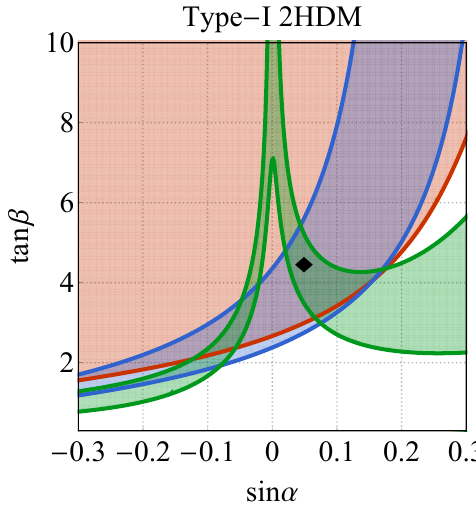
Figure 2 . Allowed/favoured regions in the type-I 2HDM parameter space. The constraint shown in red is obtained from the compatibility with the LHC Run-I Higgs signal strengths [1], the blue region indicates the area consistent with the LEP excess [8], while the green contour represents the parameter regions in which the di-photon H signal strength at [0 : 04 ; 0 : 10] pb. The diamond ( (cid:7) ) corresponds to the benchmark scenario (3.1). See text for further